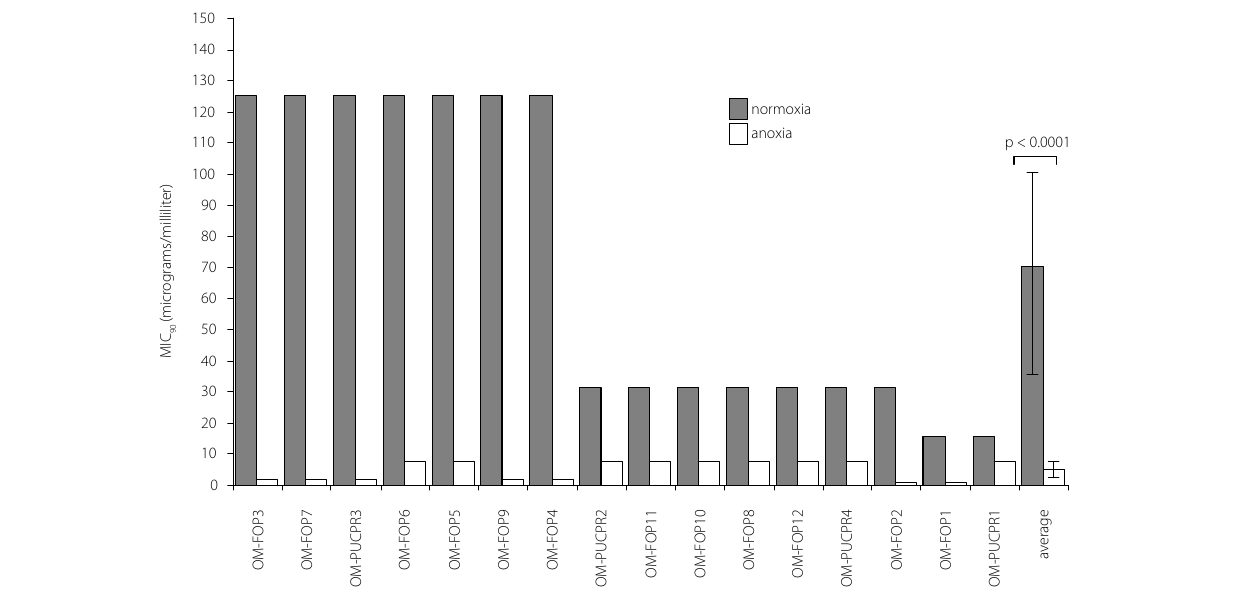
Figure 2. Minimum inhibitory concentration (MIC) of chlorhexidine digluconate for mucosa-related (OM) Candida albicans strains in normoxia and